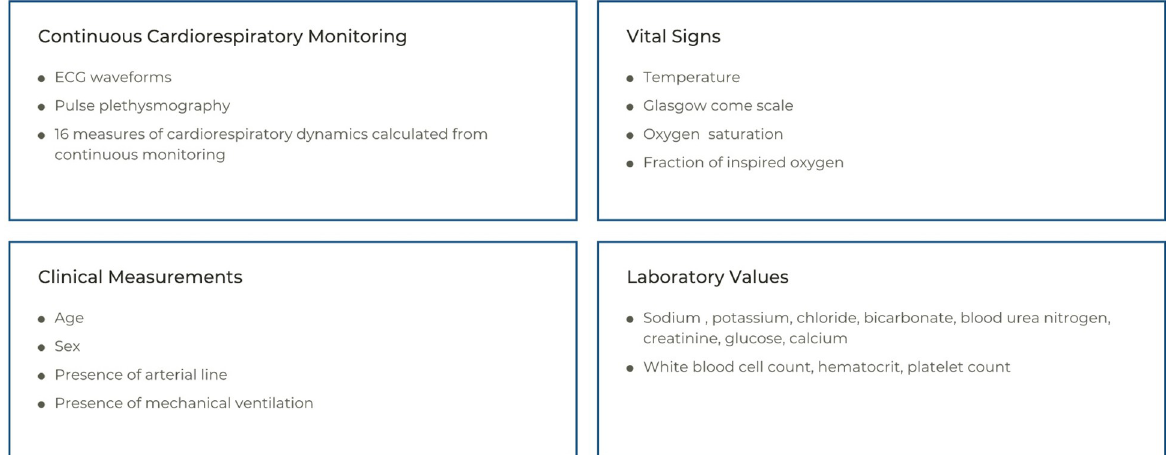
Fig 1. Data inputs to the sepsis prediction model. Inputs to the sepsis prediction model include clinician-entered vital signs, clinical measurements, laboratory values, and features derived from continuous cardiorespiratory monitoring. Features derived from ECG waveforms and pulse plethysmograpgy include the mean and standard deviation of heart rate, respiratory rate (RR), pulse oximetry (SO2), blood pressure, the three pairwise cross-correlations between HR, RR, and SO2, standard deviation of heart inter-beat intervals, local dynamics score (a measure based on the way in which interbeat RR intervals match), local dynamics density of heart inter-beat intervals, coefficient of sample entropy, and the slope of log variance versus log scale between scales 4 and 12 for detrended fluctuation analysis of heart inter-beat intervals.